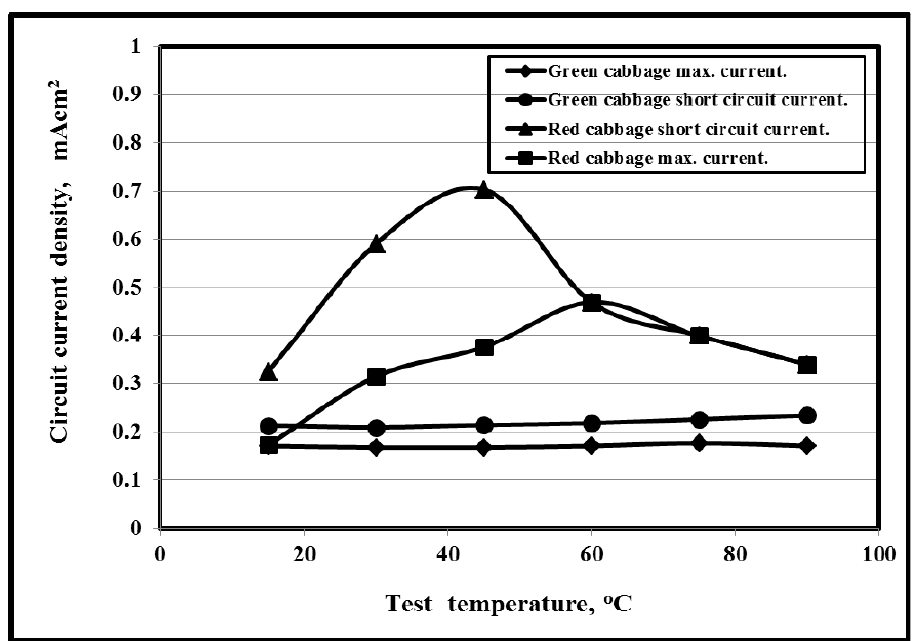
Figure 12. Im and Isc/temp. relation for RC and GC solar cells.